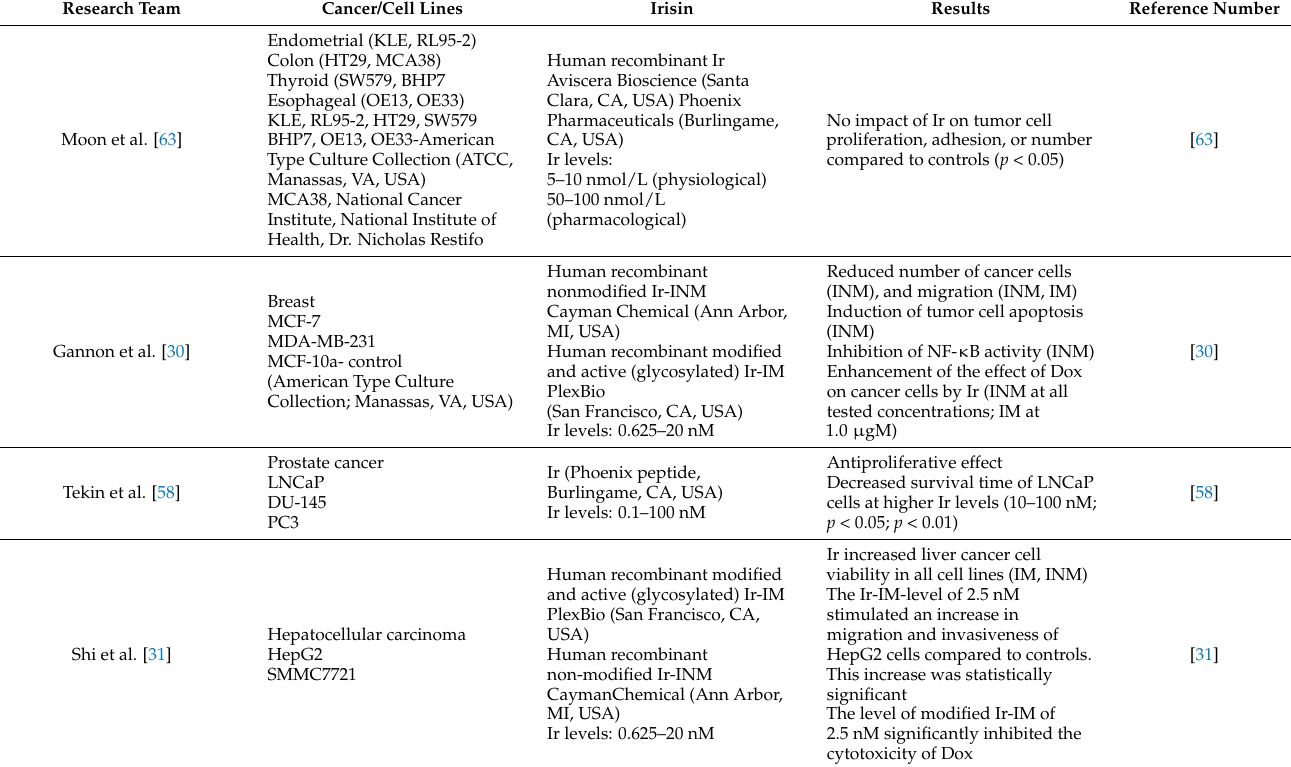
Table 1. Summary of the results of Irisin levels in in vitro model